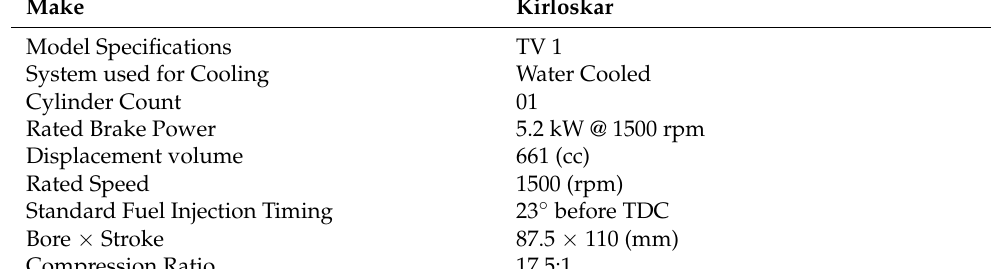
Table 3. Feature set of the engine used here for conducting the experimentation.